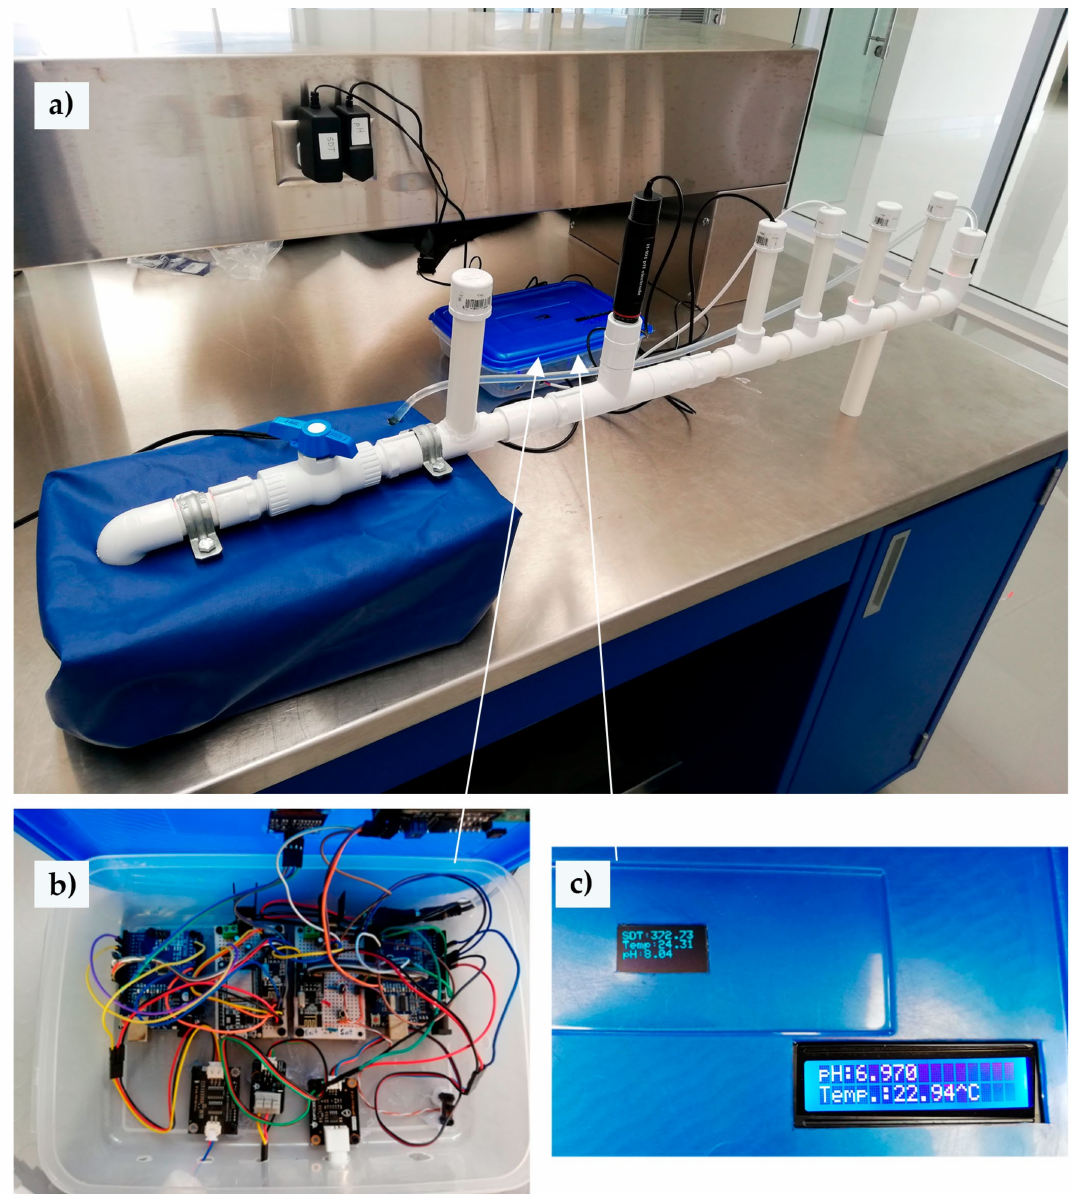
Figure 3. ( a ) PVC pipe structure with a pump for water recirculation for indoor multinode testing of IoT-WQMS, ( b ) IoT multinode designed for indoor testing, ( c ) OLED and LCD displays added for local verification of